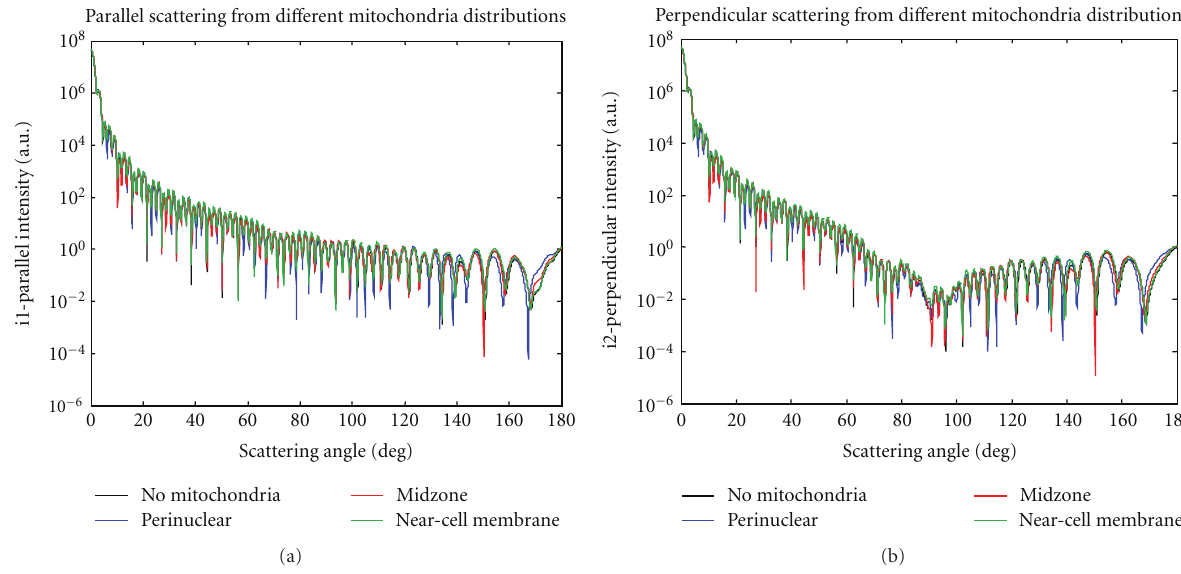
Figure 4: Scattered intensities as a function of scattering angles for di ff erent mitochondria distributions. (a) i 1 parallel polarization, (b) i 2 perpendicular polarization. The di ff erent colors represent di ff erent mitochondria distributions.